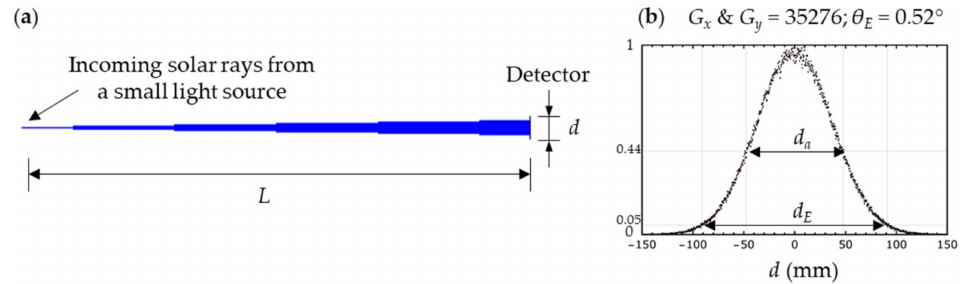
Figure 9. ( a ) Light propagation from a small light source towards a detector of size d at distance L . ( b ) Solar–terrestrial image with solar half-angle ( θ E ) of 0.52 ◦